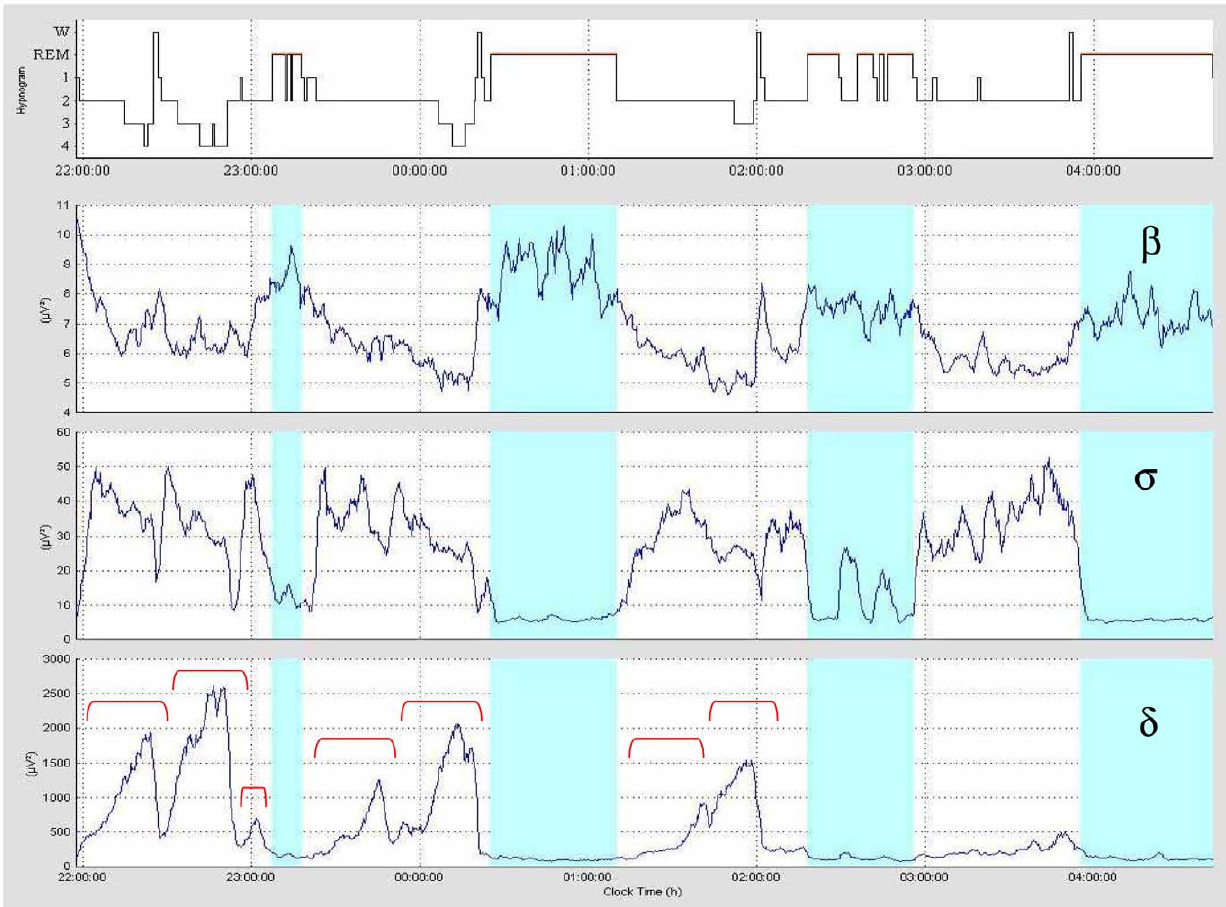
Figure 1. Sleep structure across NREM-REM sleep cycles 1 to 4 for a typical subject. Spectral power time-course data in the major frequency bands: beta ( b ) 18–25 Hz; sigma ( s ) 12–15 Hz and delta ( d ) 1–4 Hz, together with the corresponding hypnogram in the uppermost panel. W=wake; REM=REM sleep (shaded blue); 1, 2, 3, 4=NREM sleep stages. The total duration of the time-courses is 6 h 50 min with the hours indicated by vertical dashed lines. Note the repeated alternations between going towards deep sleep (delta rising) and going away from deep sleep (delta falling) in each NREM episode. This is best visualised on the delta panel. Towards -and- away cycles (indicated by a red bracket) constitute the basic building blocks of the NREM episode.